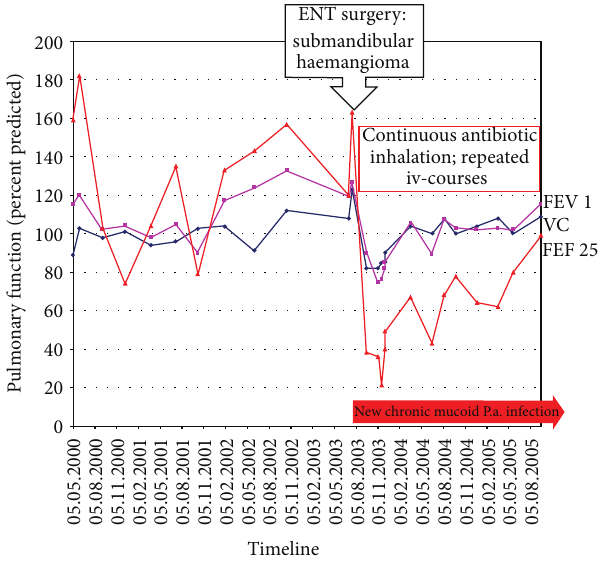
Figure 2: Progress of pulmonary function of patient number 1.